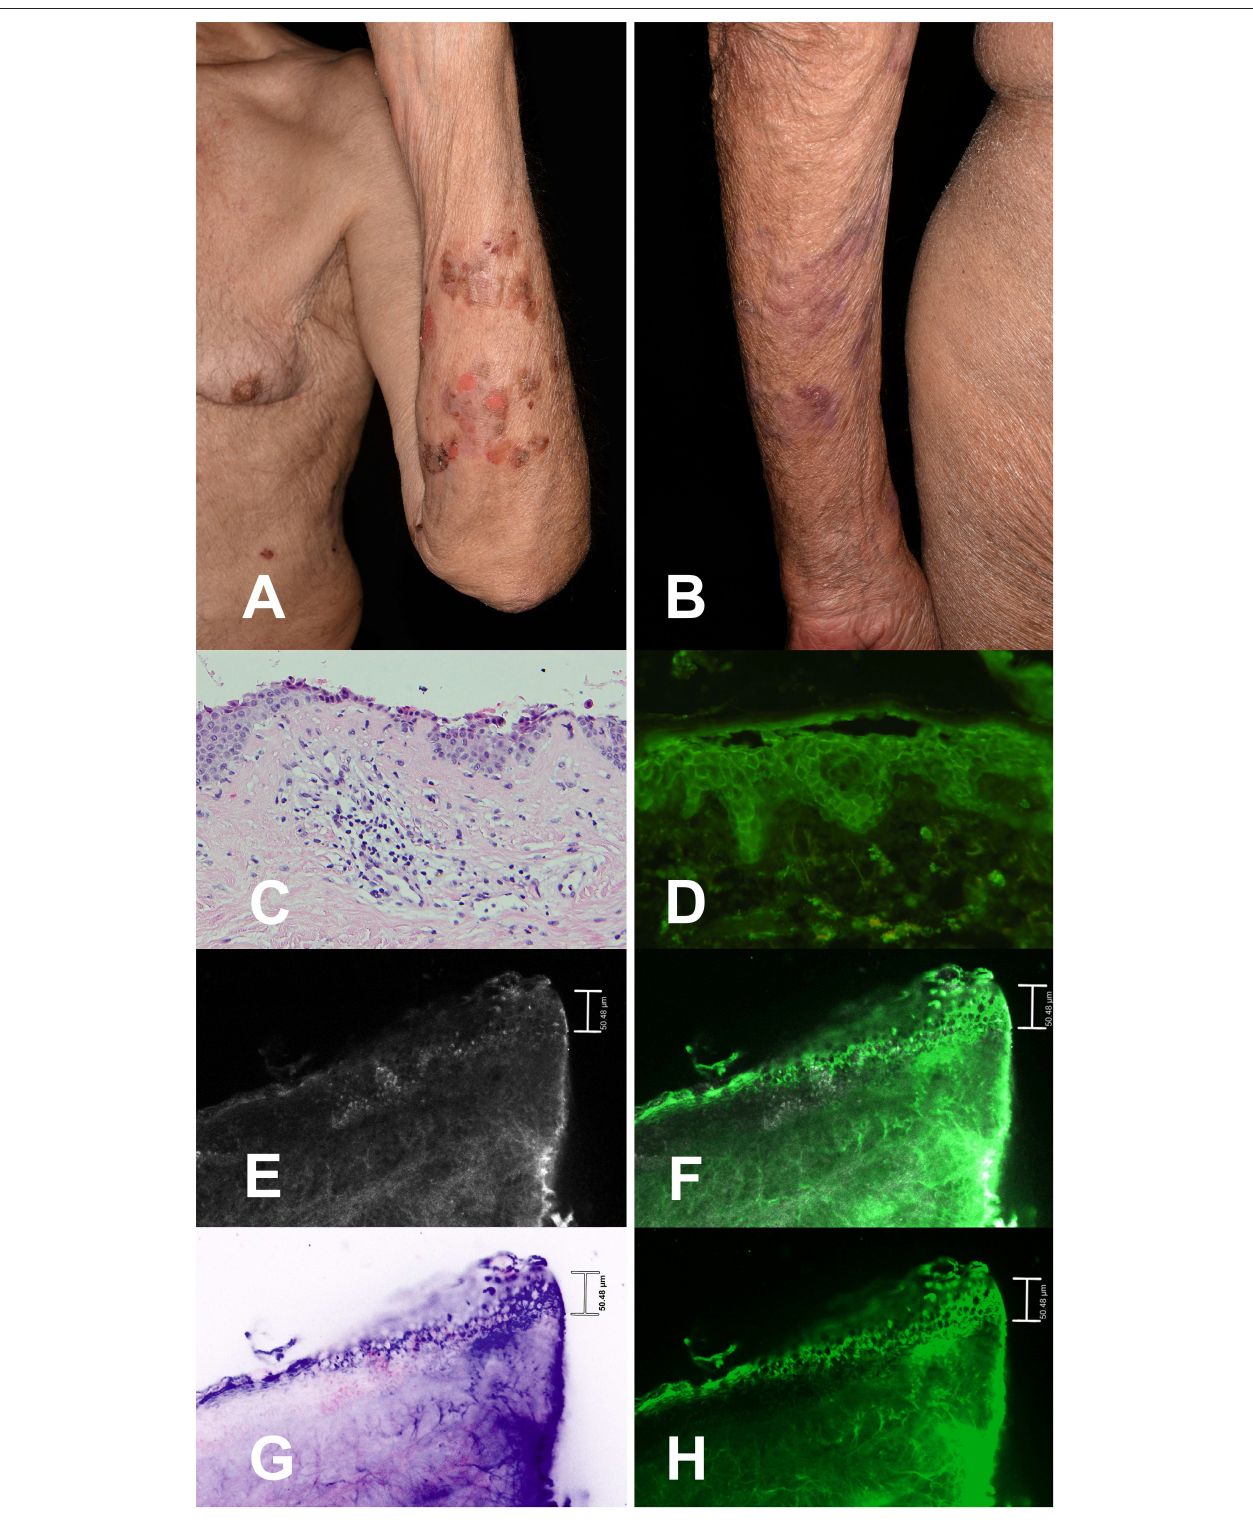
FIGURE 2 | Pemphigus vulgaris lesions on the left forearm of a patient with lung adenocarcinoma treated with nivolumab showing multiple erosions and hemorrhagic crusts. Fresh blisters are not present anymore (A) . Skin condition of the patient 4 weeks later under therapy with prednisolone 20mg daily and methotrexate